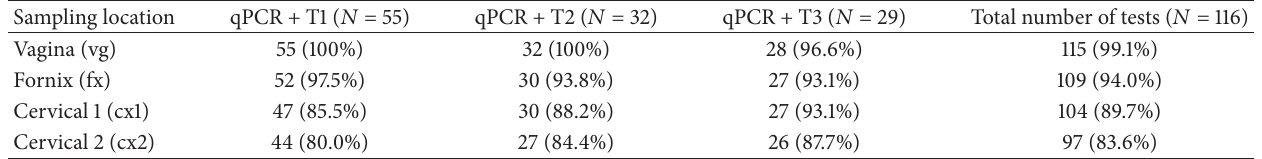
Table 1: Number ( 𝑁 , %) of positive samples per location and per trimester in qPCR+